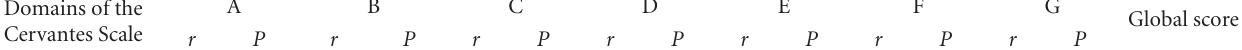
Table 2: Correlation between the domains and subdomains of the brazilian portuguese version of the cervantes scale. Domains of the